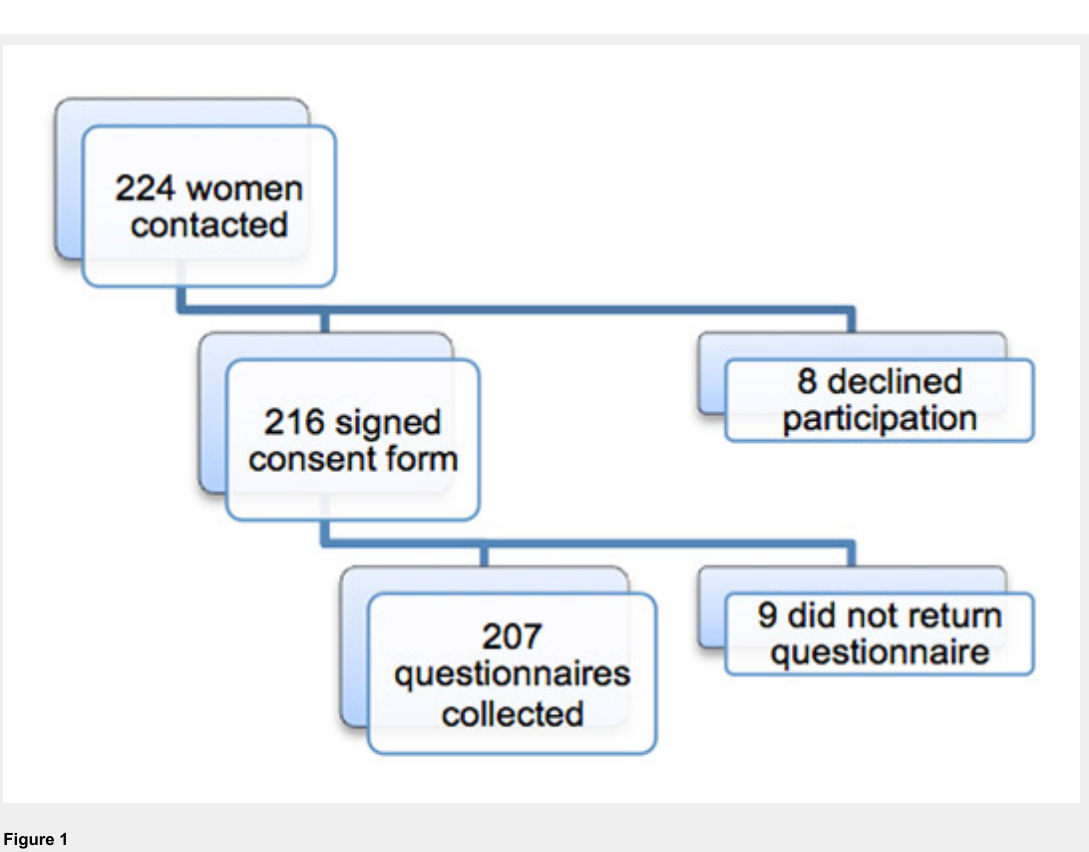
Figure 1 Inclusion of the study